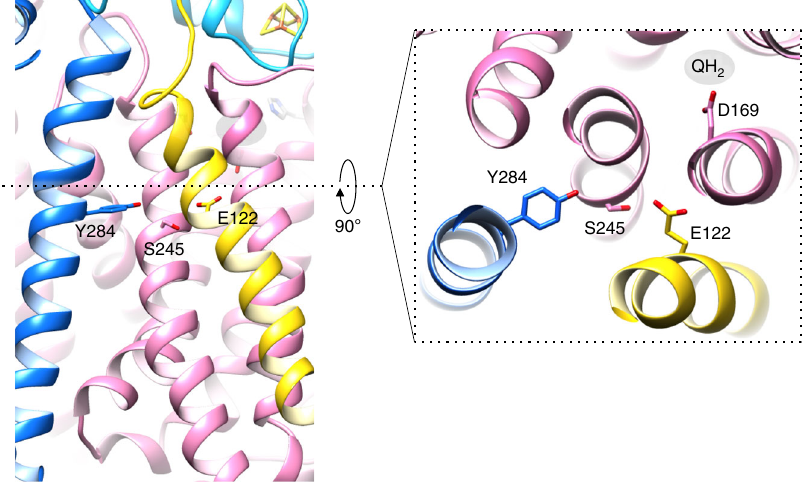
Fig. 7 Inter-subunit cross-talk. Interface between ActC, ActF, and ActD in ACIII, as seen from the membrane (left) and from the periplasm (right). The highly conserved Glu122 D , Ser245 C , and Tyr284 F are aligned in the central plane of the membrane, and are each 3 – 5 Å apart from their closest neighbor. Glu122 D is ~8 Å from Asp169 C , which is part of the putative quinol-binding site. Subunits colored as in Fig. 1. Density for aspartate and glutamate residues is not visible and their side chains have been